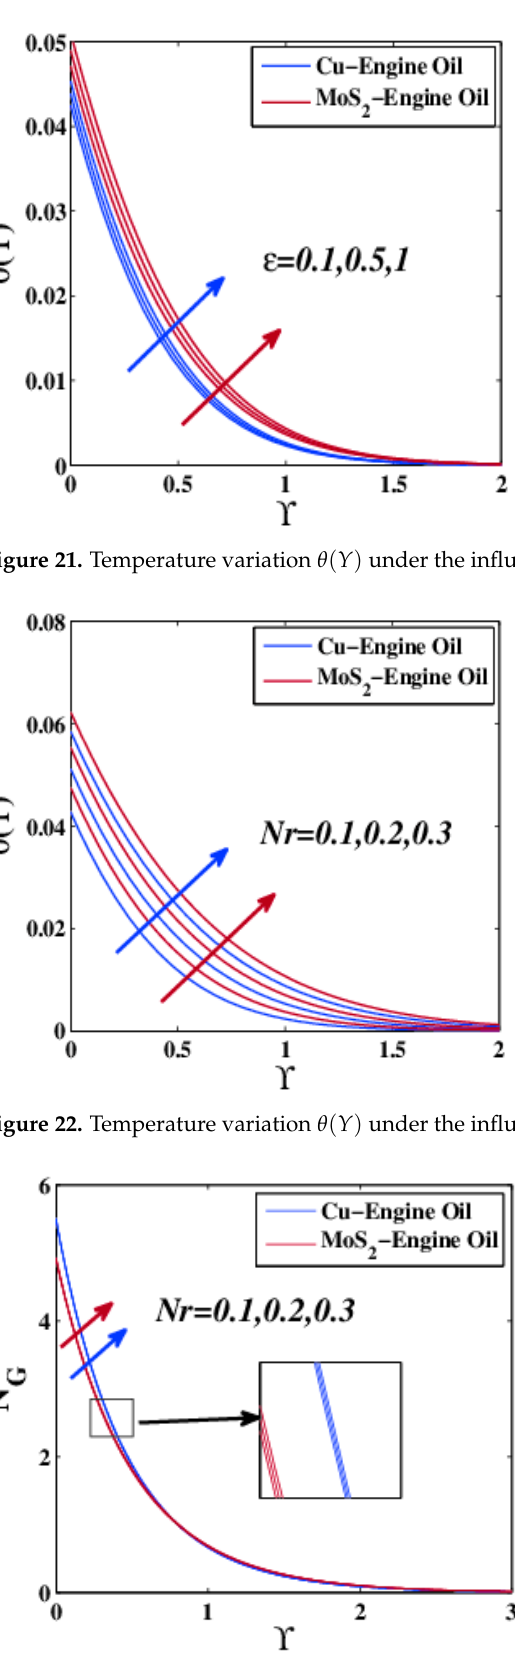
Figure 20. Entropy generation variation 𝑁 (cid:3008) under the influence of 𝐵 (cid:3098) .